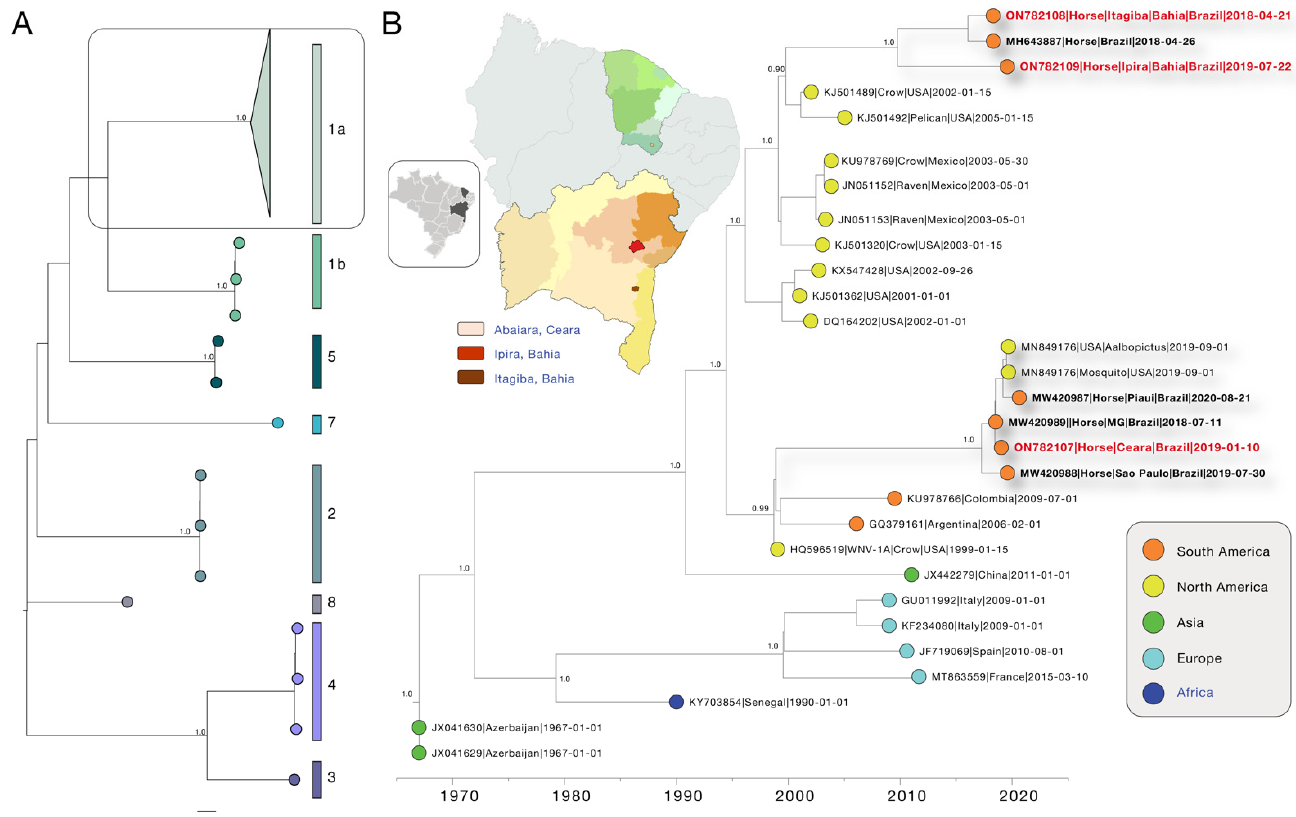
Figure 1. Genomic monitoring of WNV in northeastern Brazil. ( A ) ML reconstruction showing major linages of WNV, including n = 2152 genome sequences plus the three new strains obtained from this study. The scale bar is in units of substitutions per site ( s / s ). Support for the branching structure is shown by bootstrap values at nodes. The highlight indicates that the new genomes belong to the 1a lineage. ( B ) Map of Brazilian Northeast Region, highlighting the states of Bahia and Cear á . Time-scaled maximum clade credibility phylogeny of WNV, including the two new genomes generated in this study plus n = 26 reference strains. Tips are colored according to the sampling location. Values around key nodes represent posterior probability